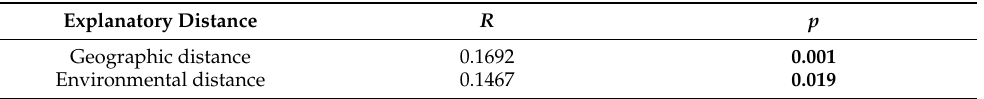
Table 2. Mantel test for the correlation of fungal community dissimilarity with environmental distance and geographic distance.